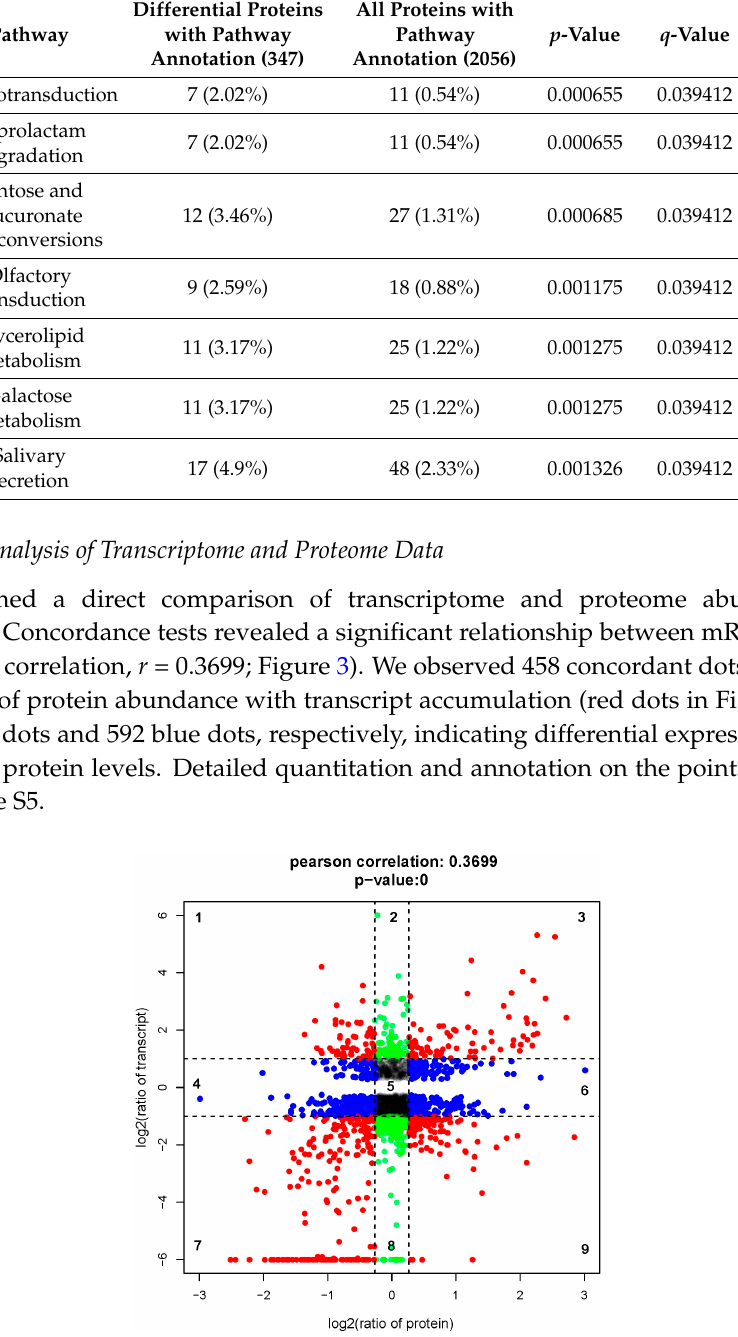
Table 3. Seven enriched pathways identified with KEGG analysis of differentially expressed proteins.